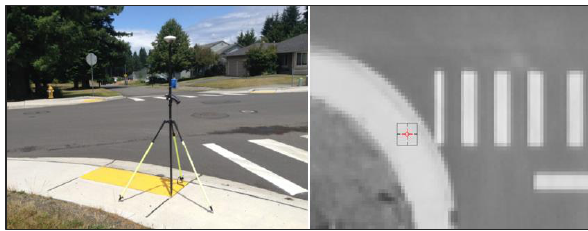
Figure 4. Contrast of a yellow feature is undetectable in the